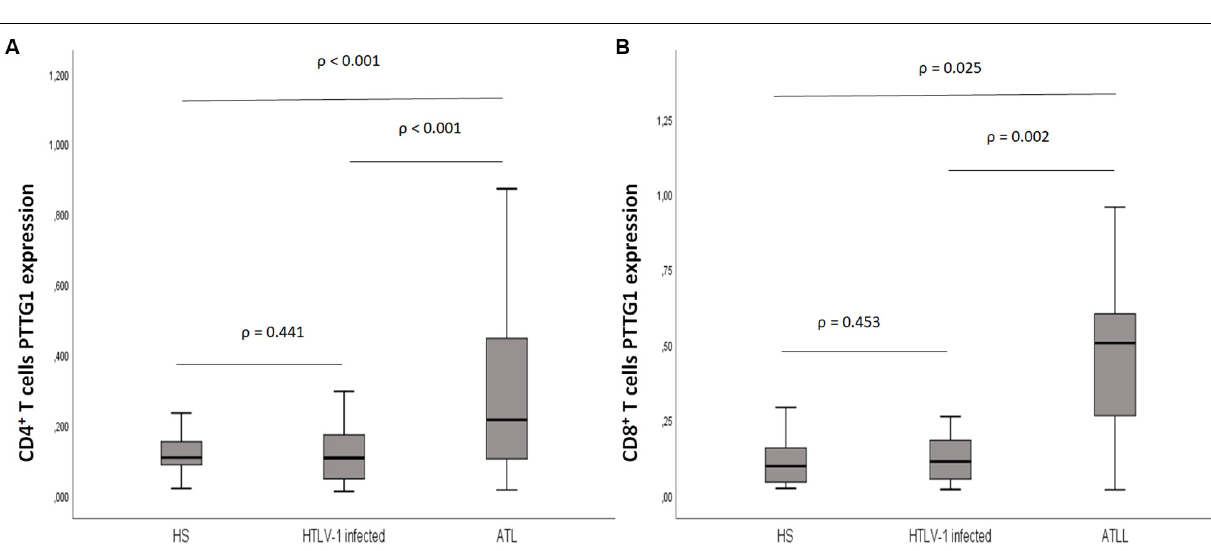
in the CD8 + T cells and the percentage of cells in G 2 /M was found ( R 2 = 0.516; p = 0.002). No correlation was observed between PTTG1 expression in CD8 + T cells and the percentage of cells in S-phase for HTLV-1 infected ( R 2 = 0.016; p = 0.911)